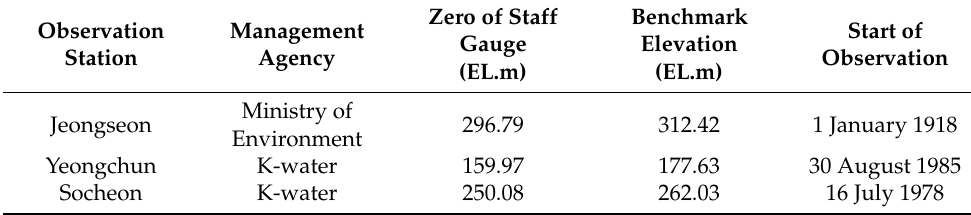
Table 4. Specifications of the streamflow